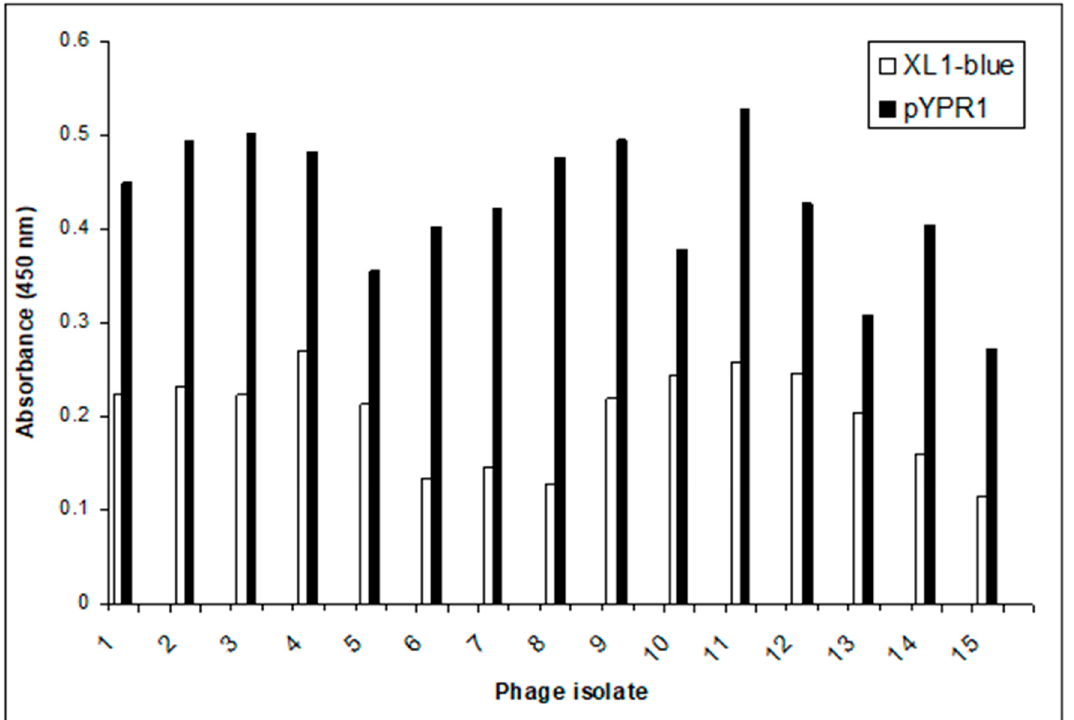
Figure 1. Y. pestis F1 antigen phage Spun-Cell ELISA. The binding ability of each phage isolated ( x -axis) after the 3rd round of biopanning against the Y. pestis F1 antigen was tested through a Spun-Cell ELISA, comparing A450 nm values ( y -axis) of the E. coli XL1-blue/pYPR1 strain and the parent E. coli XL1-blue strain. As seen, each phage isolate tested bound to the pYPR1 cells at a higher level than the XL1-blue cells. Phage isolate #8 showed the greatest difference between specific binding (i.e., binding to E. coli expressing F1 antigen) and nonspecific binding (binding to E. coli not expressing F1 antigen) at A450 nm, and it was selected for further characterization.